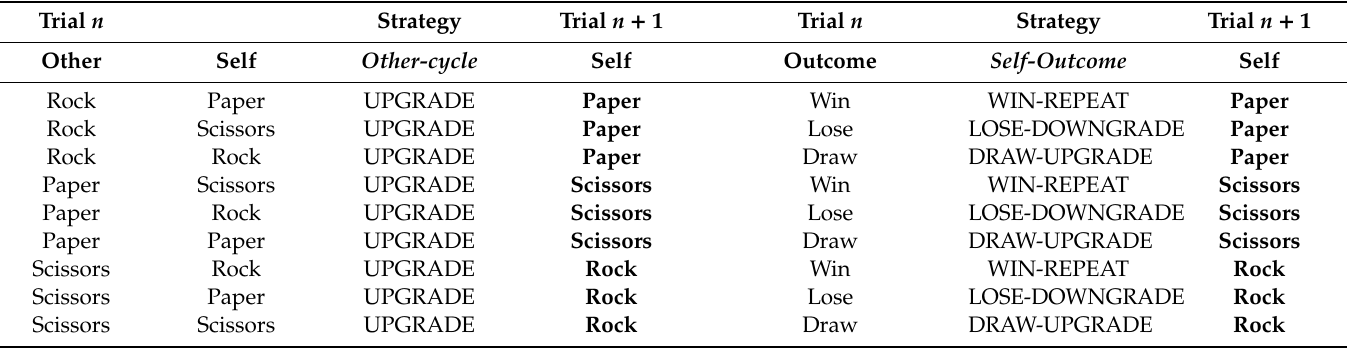
Table 1. Equivalence of deploying an other-upgrade strategy (also Cournot’s best response) and a traditional self-outcome strategy. Trial